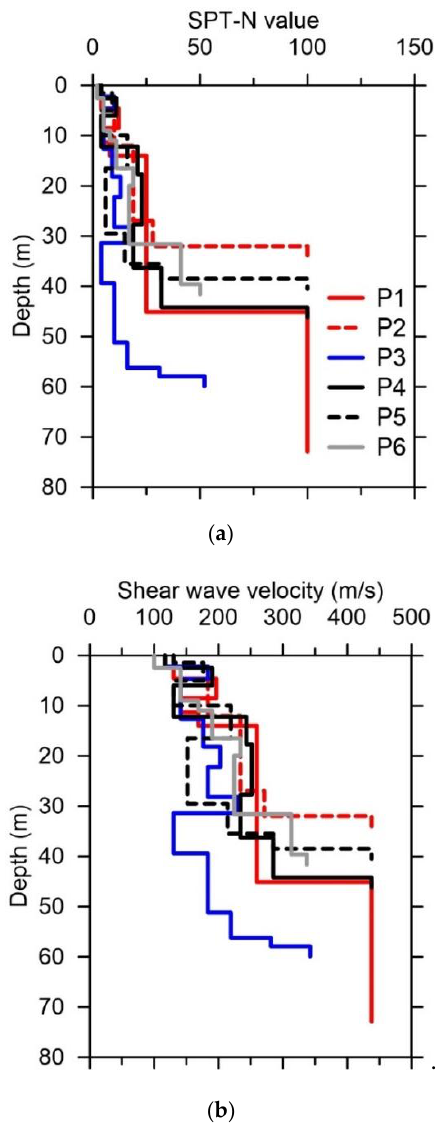
Figure 5. Selected soil profiles: ( a ) SPT-N value, ( b ) shear wave velocity.